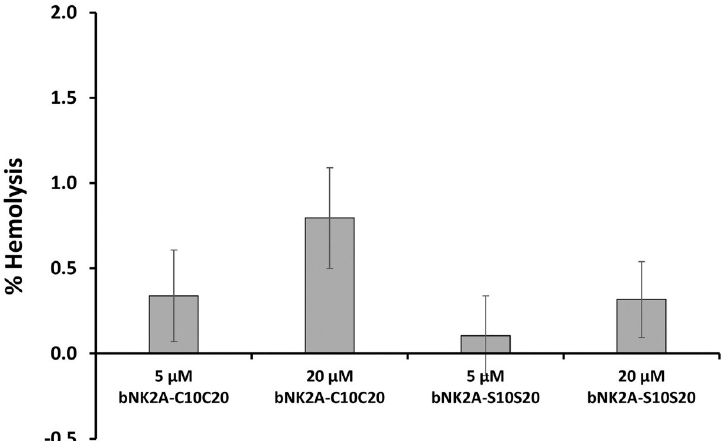
Fig 5. Both bNK2A peptides showed minimal hemolytic activity against cattle erythrocytes. The cattle RBCs resuspended in PBS (2.5% hematocrit) were incubated with original bNK2A-C10C20 or analog bNK2A-S10S20 peptides (5 μ M and 20 μ M final concentrations) at 37˚C in a humidified atmosphere for 60 min. The released hemoglobin was spectrophotometrically measured at 405 nm wavelength using a microplate reader. RBCs incubated with 0.1% (v/v) Triton X-100 or PBS served as positive and negative controls, respectively. Means and SD were calculated from two independent experiments.